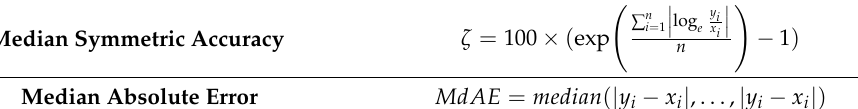
Table 4. Statistical error metrics, where y i and x i represent the modeled value and in situ measured value,